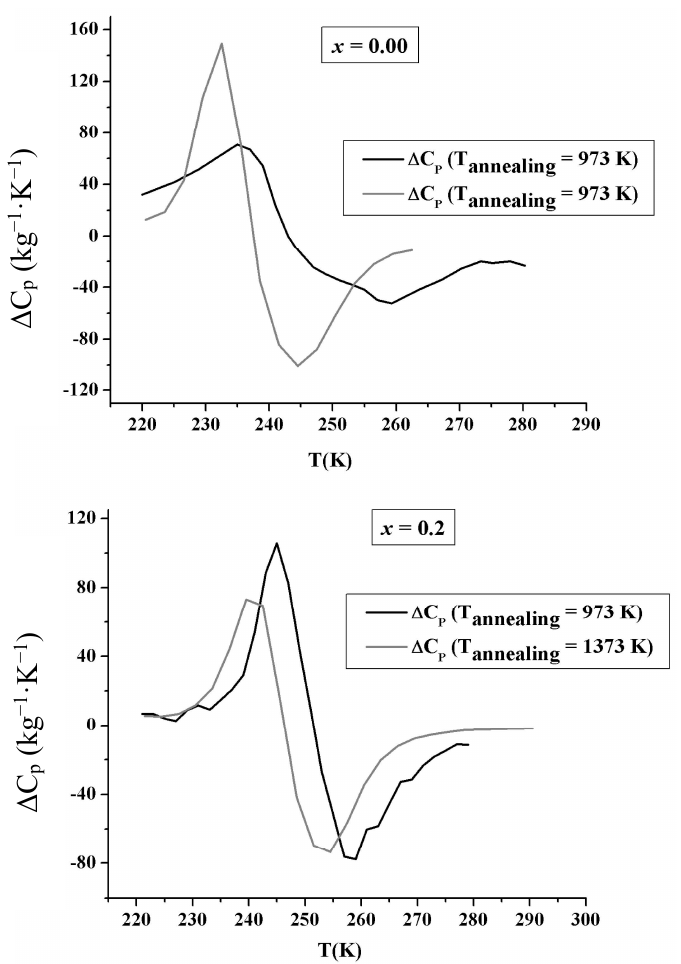
Figure 6. Change of specific heat ∆ Cp as a function of temperature calculated for an applied magnetic field of 2 T for La 0.8 − x (cid:0) x Ca 0.2 MnO 3 ( x = 0, 0.1 and 0.2) samples annealed at 1373 and 773K.